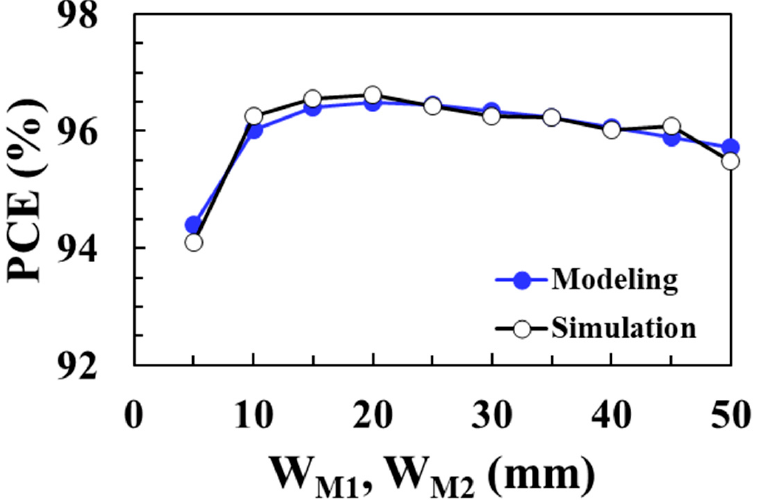
Figure 16. PCE according to switch width for an input voltage of 0.1 V and comparison with the modeling results.